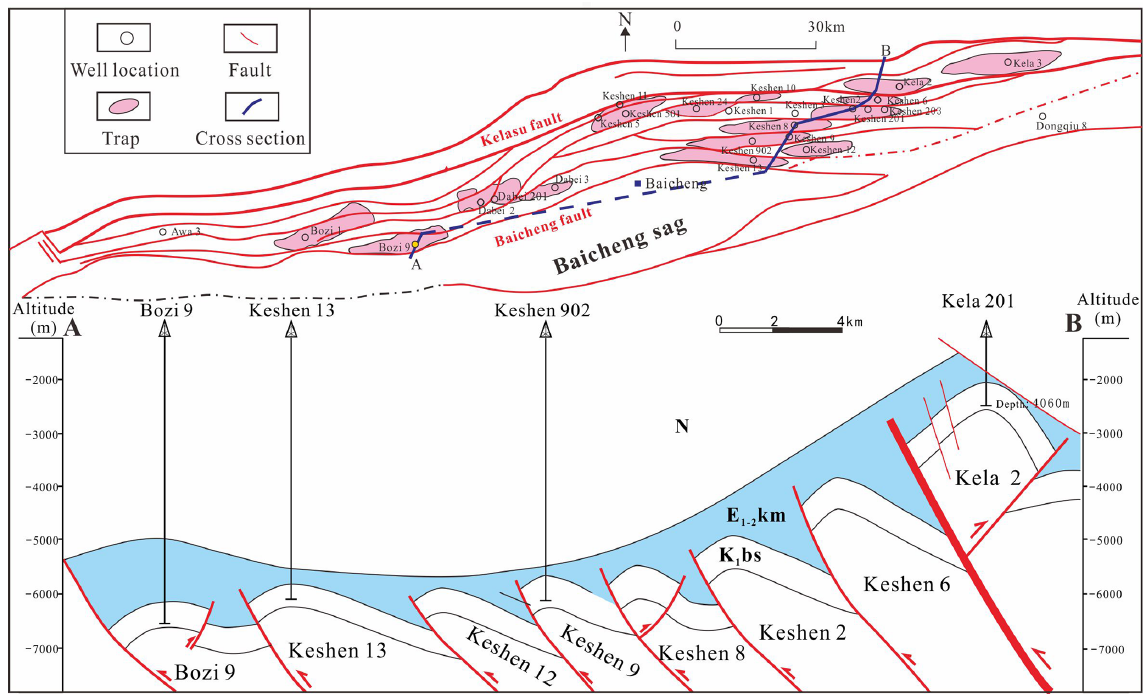
Figure 1. Map showing the structural divisions of the study area (Jin et al., 2008; Lai et al., 2017b; Wei et al., 2020).